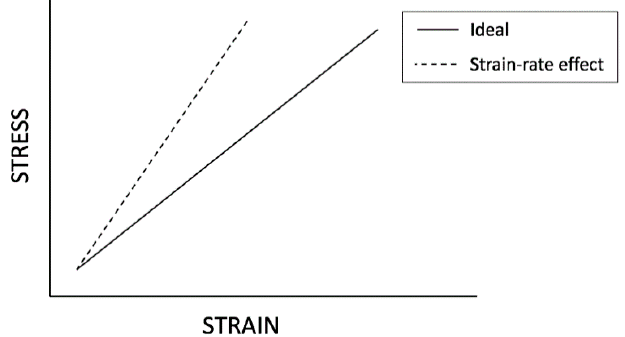
Figure 5. Representation of stress-strain behavior of metals when acknowledging the effect of strain rate.